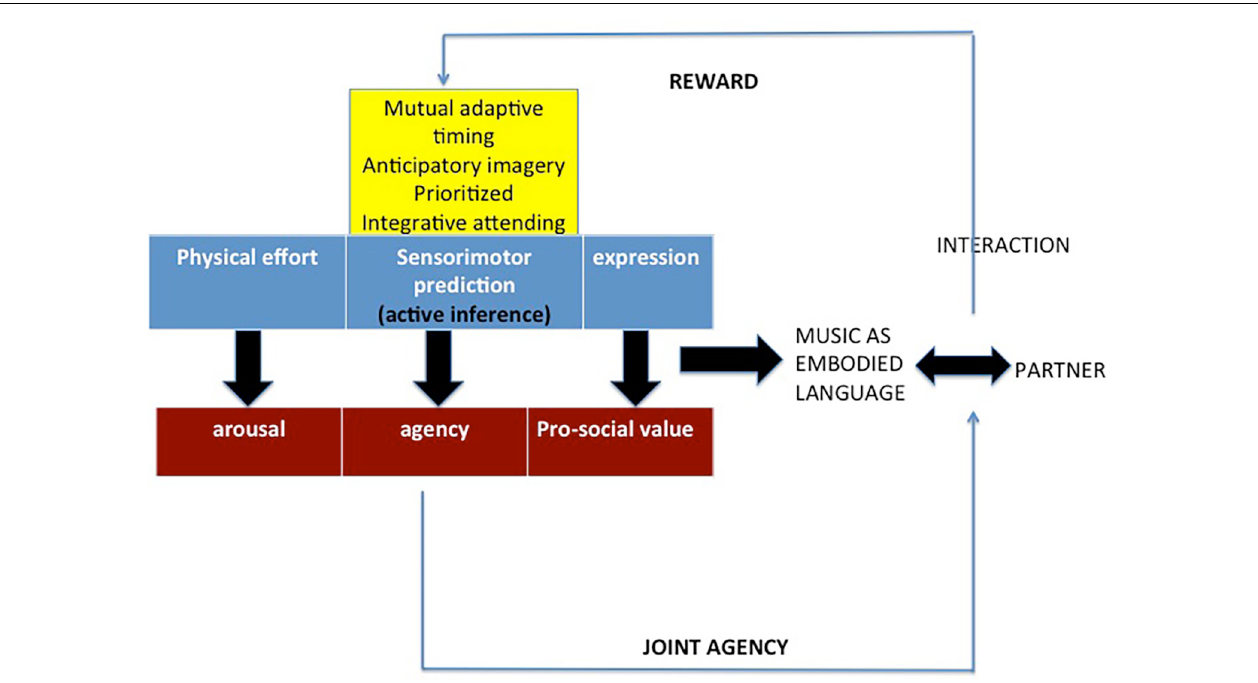
FIGURE 2 | A framework of music as embodied language. The crucial role is played by joint agency, which is a consequence of the sensorimotor prediction device, along with arousal (both arousal and joint agency are expected to cause rewarding effects). The prediction devise is based on active inference and includes Keller’s three sensorimotor competences to play music in ensemble. Some experimental evidence (concerning, for example, tapping, jazz, hocket, and tool use) can be interpreted according to this framework (see below).